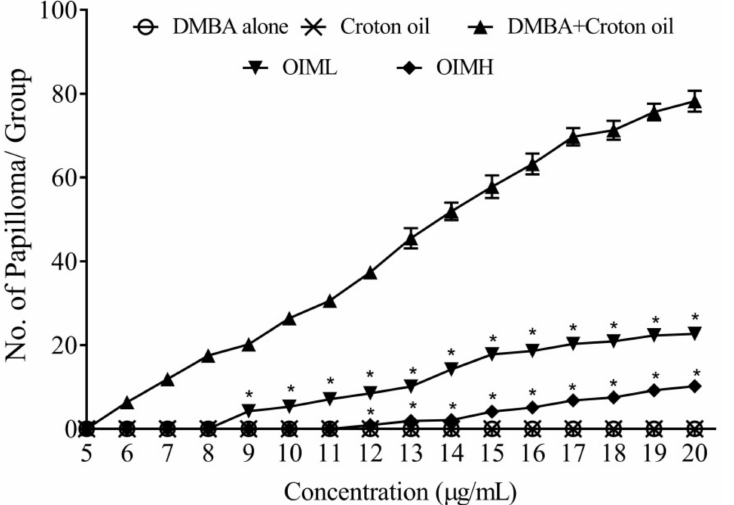
Figure 6. Effect of methanolic extract of O. indicum (OIM) on skin tumorigenesis in the DMBA–croton oil-induced animals. Group I: animals induced with 470 nmol of DMBA alone, in 200 acetone; Group II: animals induced 1% croton oil alone, in 200 acetone; Group III: animals induced with DMBA plus croton oil, which served as negative control; Group IV: [(DMBA + croton oil + OIM 5% in 200 µ L distilled water)]; and Group V: [(DMBA + croton oil + OIM 10% in 200 µ L distilled water)]. * indicate significant variation at p < 0.05 with DMBA + croton oil